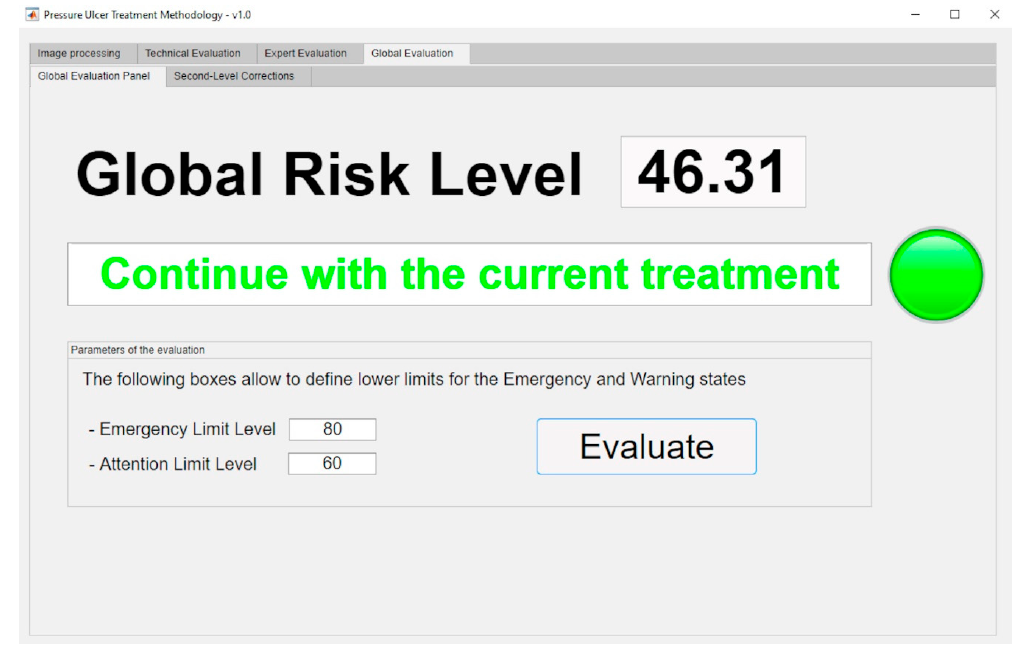
Figure 23. Evaluation panel.